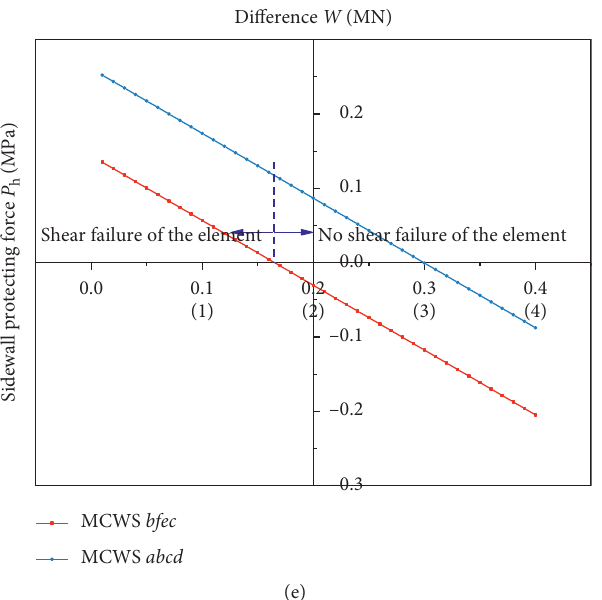
Figure 9: The impacts of the main factors on the shear failure of the element. (a) The impact of the roof load q on W . (b) The impact of the cohesion C on W . (c) The impact of on W . (d) The impact of α on W . (e) The impact of the sidewall protecting force P